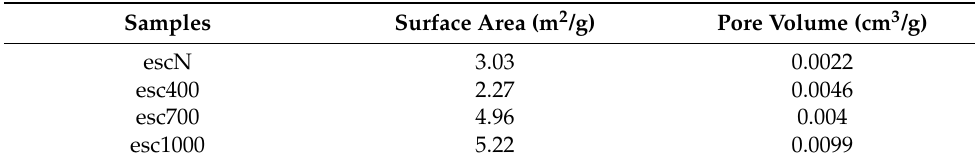
Table 1. Specific surface area and pore volume values of materials.